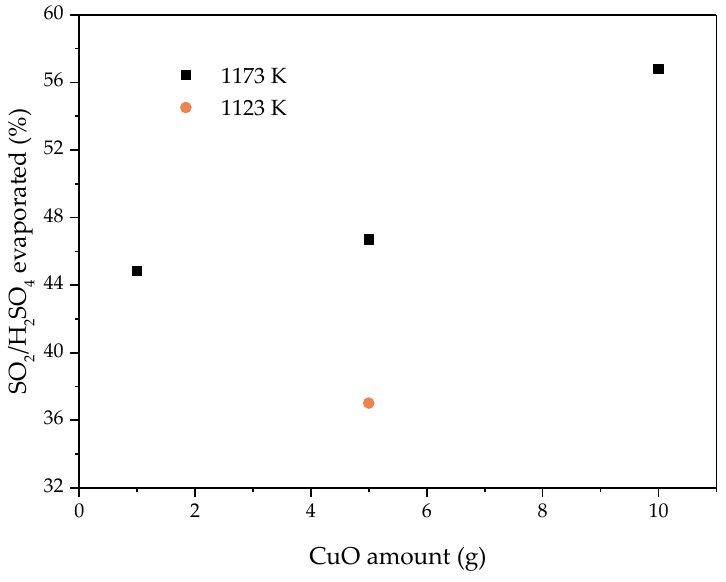
Figure 2. The SO 2 amount produced in the catalytic decomposition of H 2 SO 4 using 1 g of CuO at 1173 K.